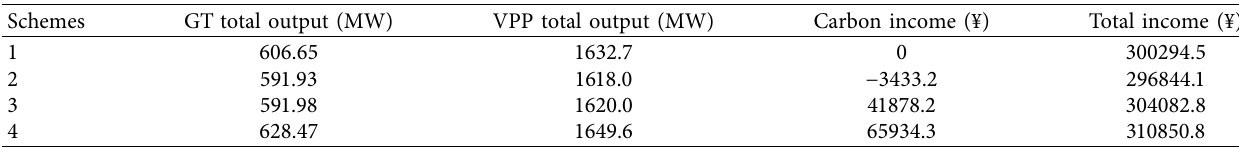
Table 3: Power output and income situation of VPP under diferent operation